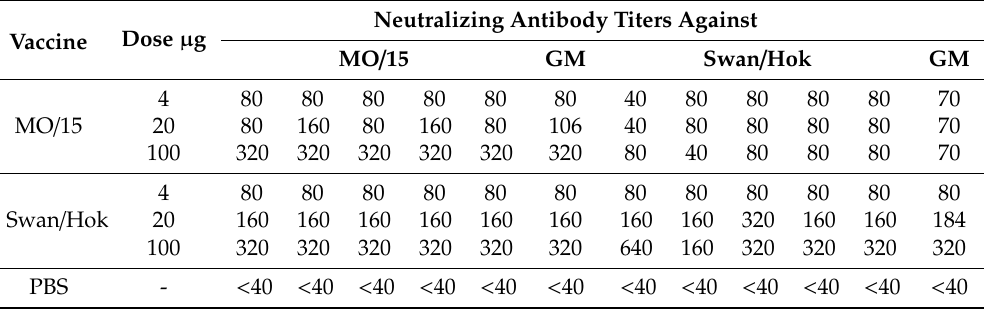
Table 2. Serum-neutralizing antibody titers of vaccinated mice. Neutralizing Antibody Titers Against Vaccine Dose µ g GM Swan /